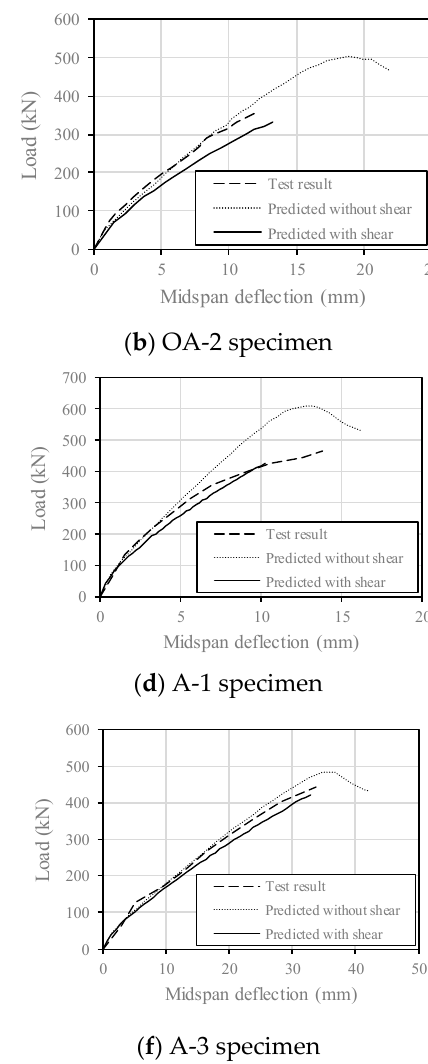
Figure 9. Load versus mid-span deflection.